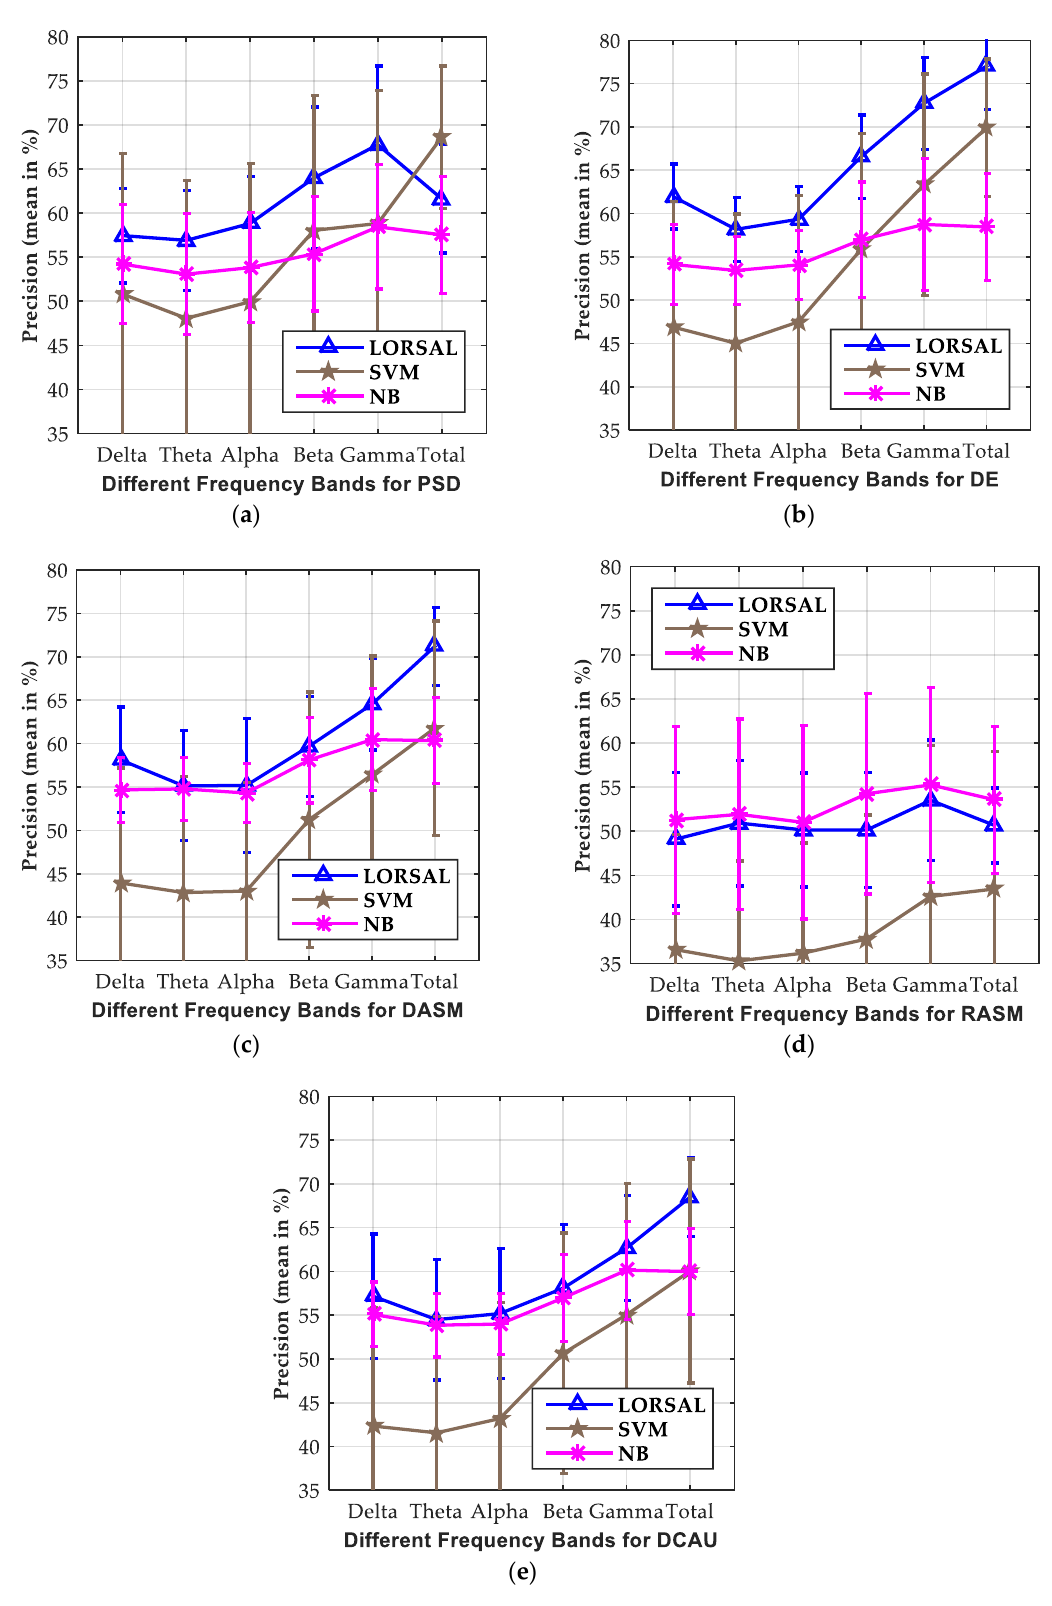
Figure 5. Effects of the different frequency bands (Delta, Theta, Alpha, Beta, Gamma, and Total) on Figure 5. E ff ects of the di ff erent frequency bands (Delta, Theta, Alpha, Beta, Gamma, and Total) on the the classification precisions for LA/HA emotions obtained by the LORSAL, SVM, and NB classifiers classification precisions for LA / HA emotions obtained by the LORSAL, SVM, and NB classifiers for the for the five different features: ( a ) PSD, ( b ) DE, ( c ) DASM, ( d ) RASM, ( e ) DCAU. five di ff erent features: ( a ) PSD, ( b ) DE, ( c ) DASM, ( d ) RASM, ( e )